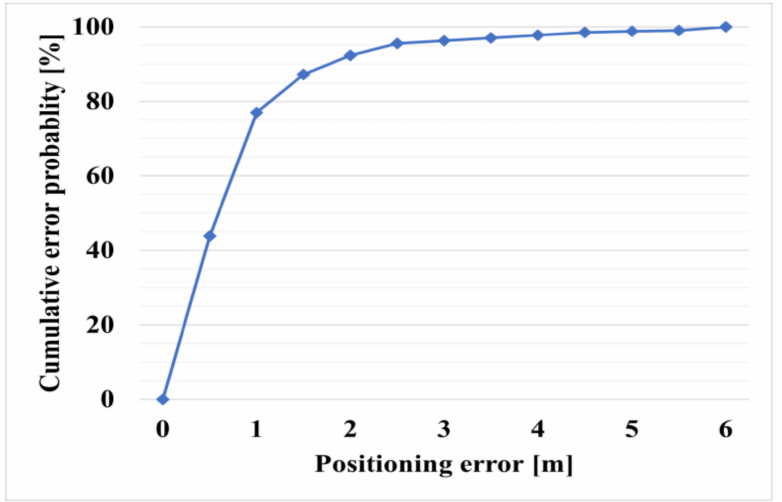
Figure 11. Cumulative distribution function (CDF) of positioning error in case of proposed system. Figure 12 shows the positioning error distance according to each reference point. The reference points of the x-axis were assigned sequentially starting from the upper right of Figure 6. The y-axis is the accuracy derived through Equation (6). The average accuracy indicated by the red dotted line is 0.10 m. Most of the results are distributed near the mean, but the index of the reference point close to the wall increases the error of the signal by 30 units. This is because the RTT signal becomes unstable due to the wall surface. Also, the closer to the area with a large index, which is an area close to a metal object, the greater the error of the signal.